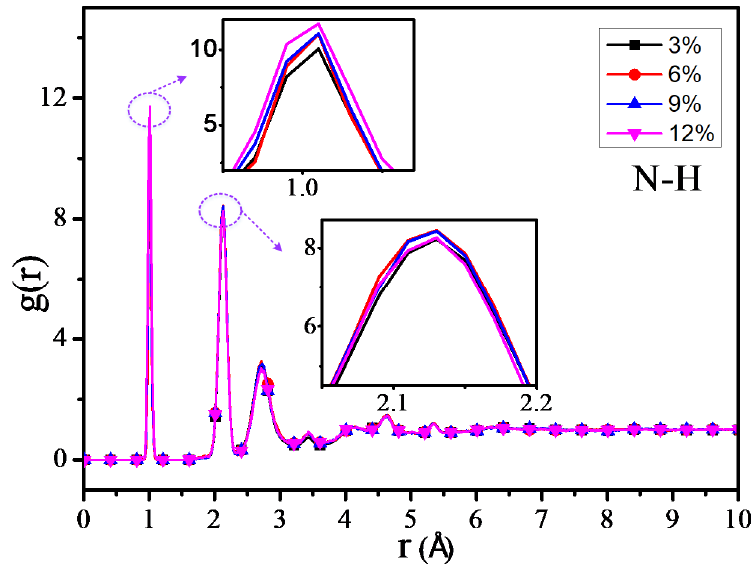
Figure 12. RDF of N–H atoms of different models.